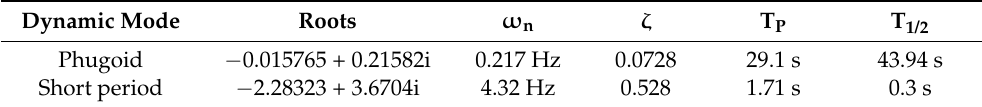
Table 22. Longitudinal dynamic stability.